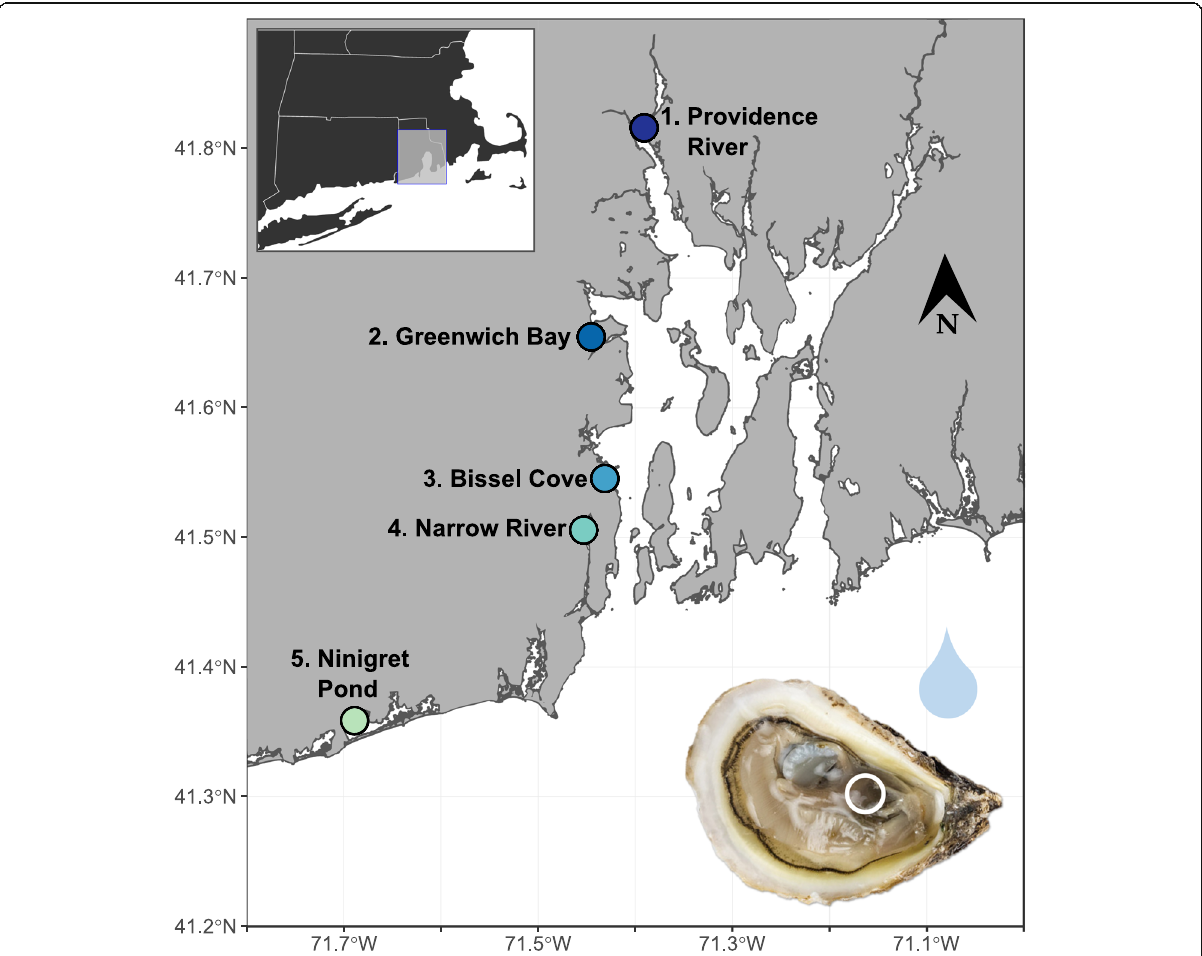
Fig. 1 Map of study area with 5 sampling locations. A schematic of the samples collected from each site is shown in the bottom